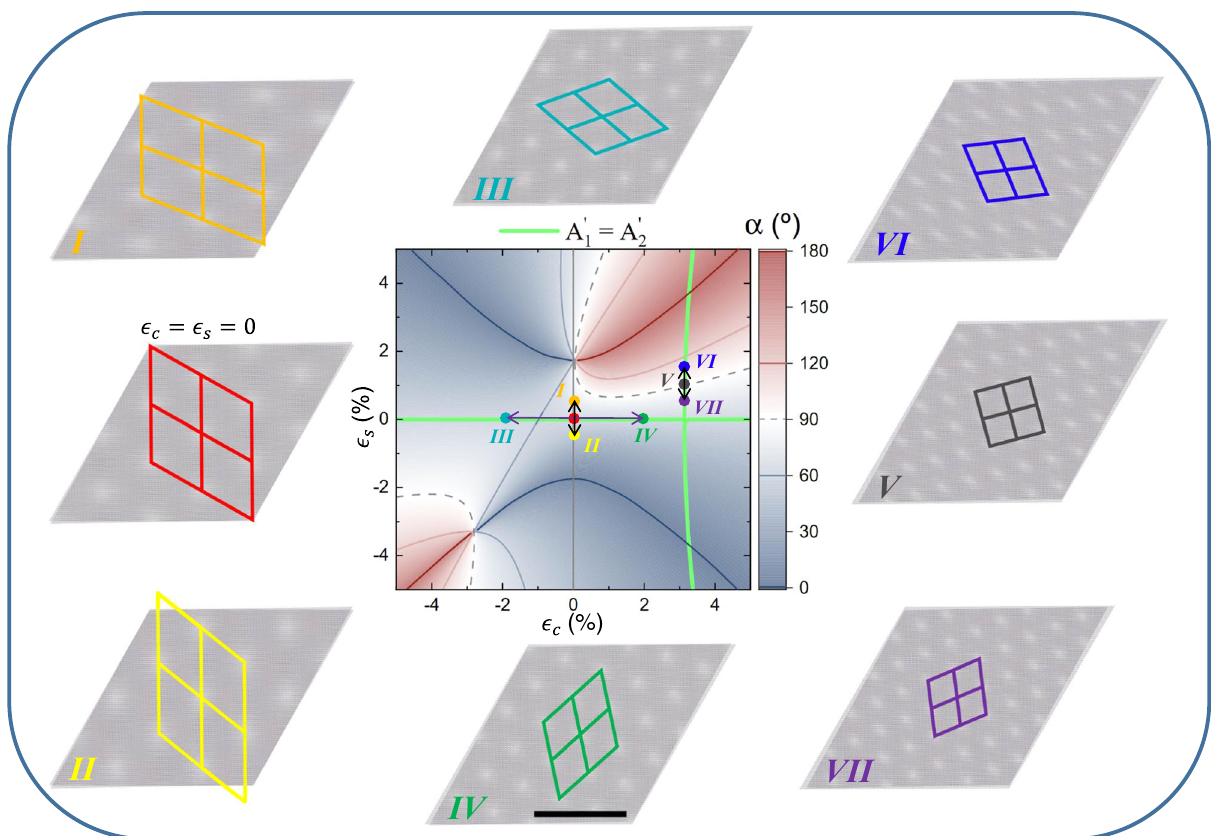
Fig. 6 Geometrical deformation of a general homobilayer stacked at θ = 1° under biaxial and shear heterostrain. Light green lines denote moiré lattices in which A 0 setup for the simultaneous control of biaxial and shear strain is shown in Supplementary Note 5. The computational script to reproduce real space images and strain animations can be found in